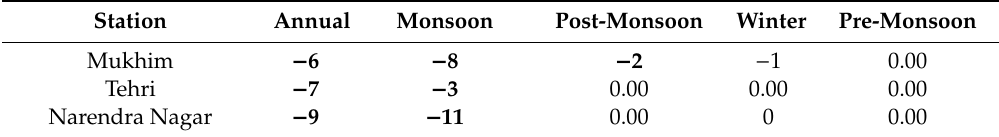
Table 6. Annual and seasonal trends in frequency of rainy days in the Bhilangana river basin (days / decade,